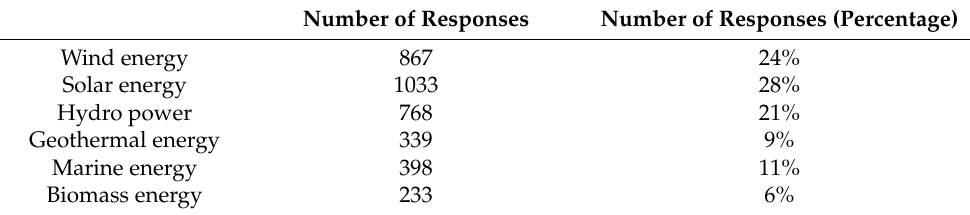
Table 2. What types of renewable energy sources do you know?